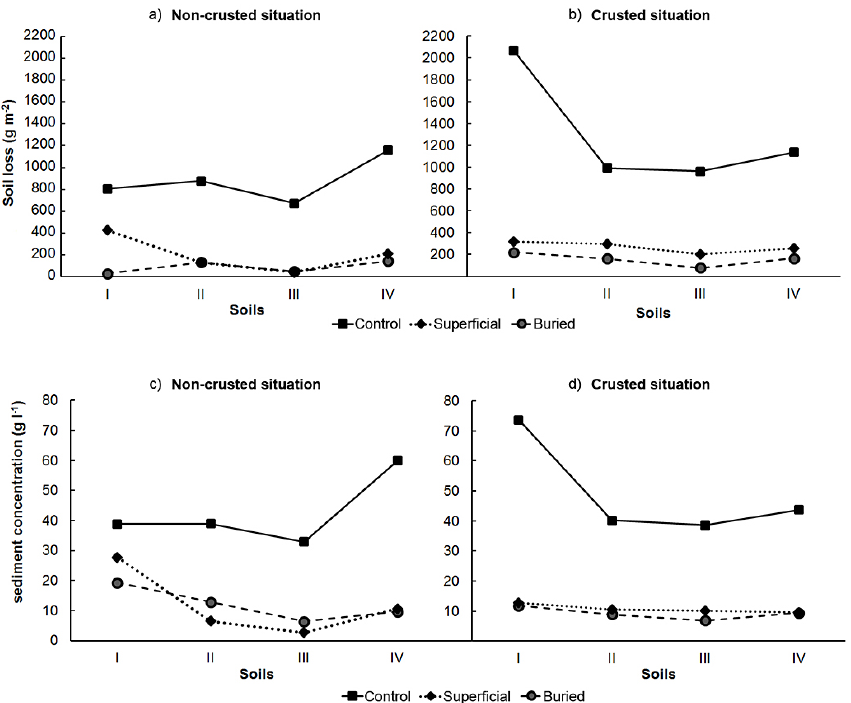
Figure 4. Behavior of erosive variables in function of the studied factors: soil loss (a) without crust, (b) with crust, and sediment concentration (c) without crust, (d) with